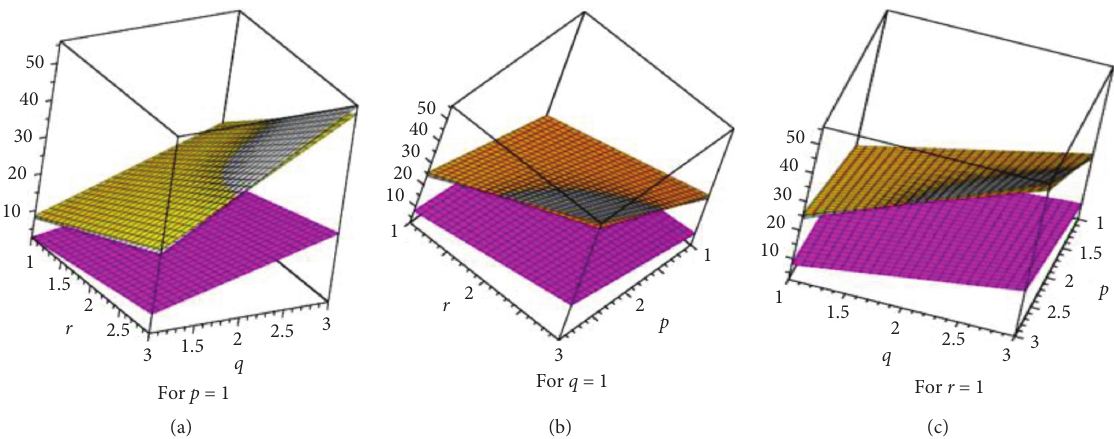
Figure 9: Comparison of IRLU , IRLA, and IRLF for crystallographic structure Cu